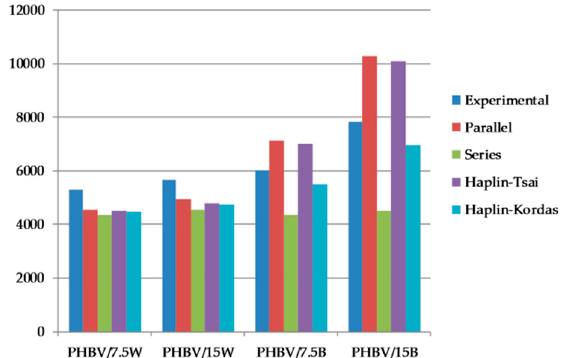
Figure 5. Comparison of experimental results with Parallel, Series, Haplin-Tsai and Haplin-Kordas micromechanical models for the Young’s modulus of composites.